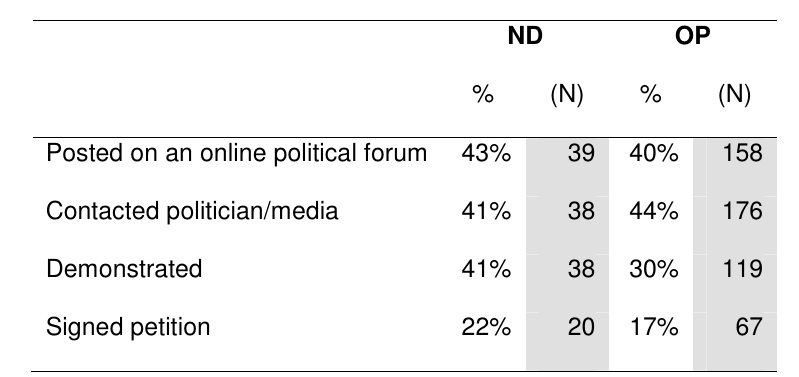
Table 6. Respondents who never engaged in any of the political activities under consideration (Author’s surveys